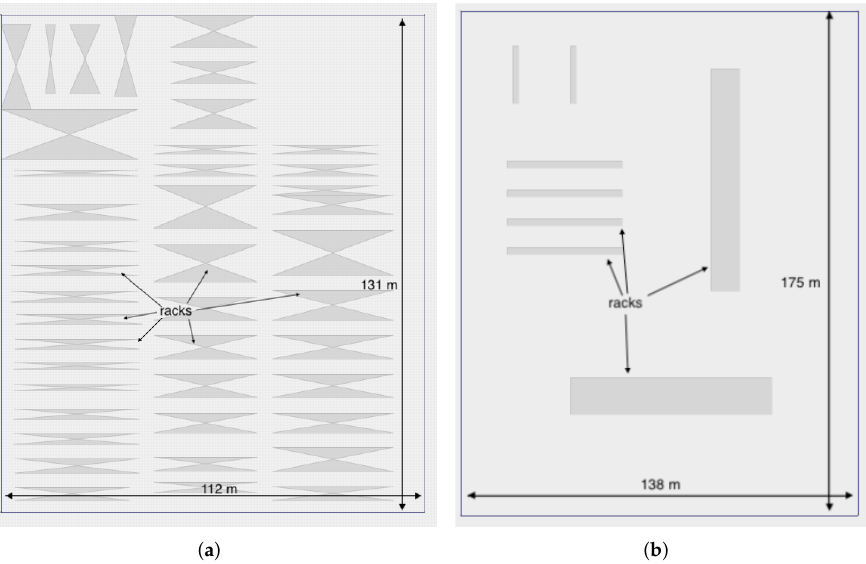
Figure 6. Floor plan of the simulation environments. Gray objects represent metallic racks. ( a ) Factory warehouse (112 m × 131 m). ( b ) Processing facility (138 m × 175